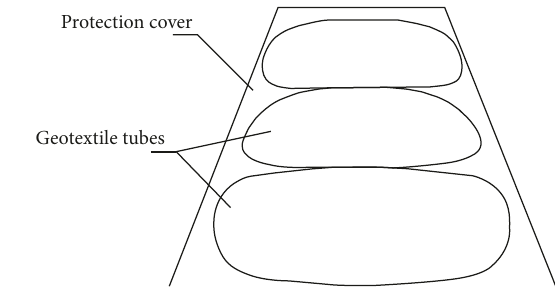
Figure 2: Illustration of geotextile tubes as a shore protection